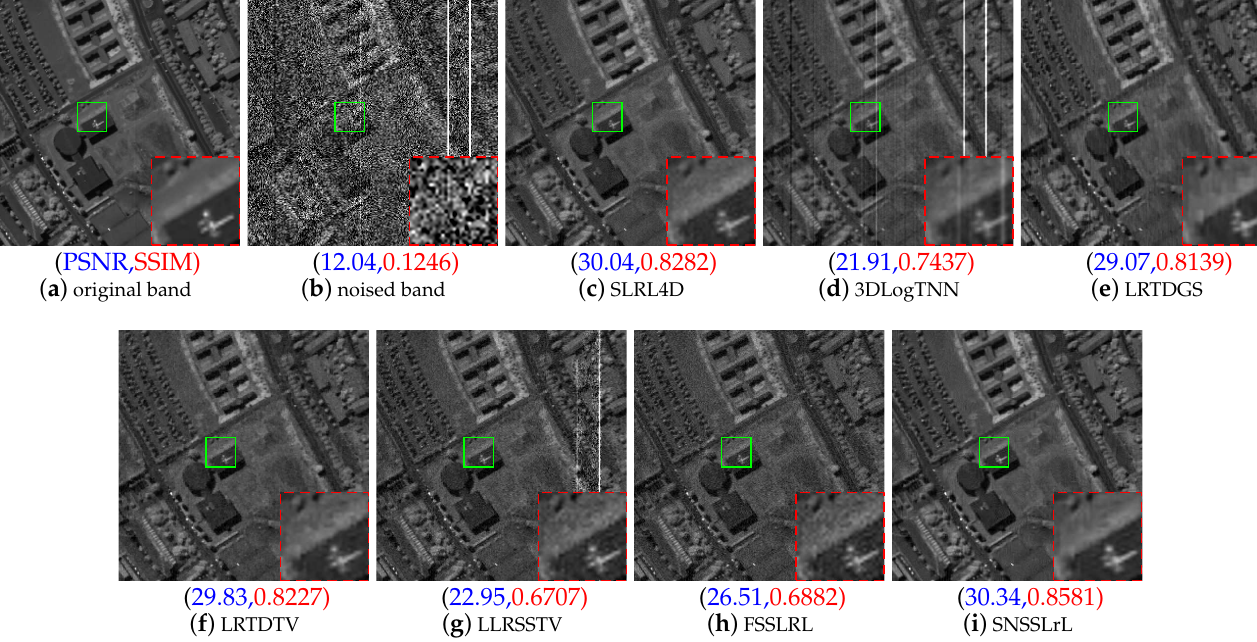
Figure 6. Band image on spectral band 82 of PU dataset under simulated Case 4. ( a ) Original band ( b ) Noised band ( c ) SLRL4D ( d ) 3DLogTNN ( e ) LRTDGS ( f ) LRTDTV ( g ) LLRSSTV ( h ) FSSLRL ( i )